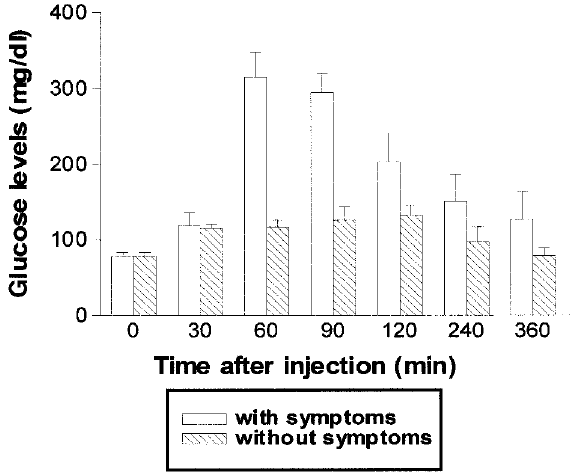
FIG. 2. Glucose determination. Groups of female mice from the BALB/c strain, 16–20g of body weight, were injected i.p. with 1LD 50 of TSV. The groups of animals were then divided into two groups: one showing symptoms, and the other not showing symptoms. The glucose levels were observed at different times. Each point represents the values of samples from two experiments ± SD in different groups of five to 15